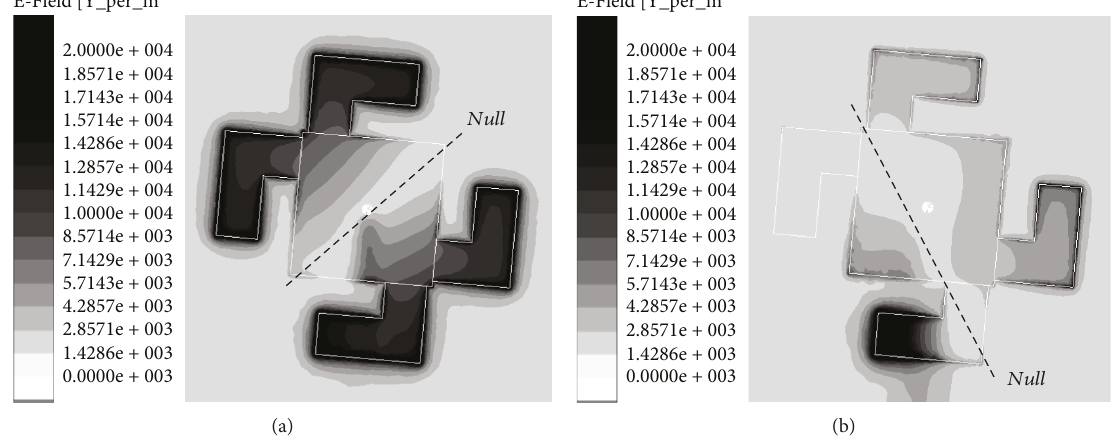
Figure 2: Simulated E- fi eld distribution: (a) 2.244 GHz and (b)